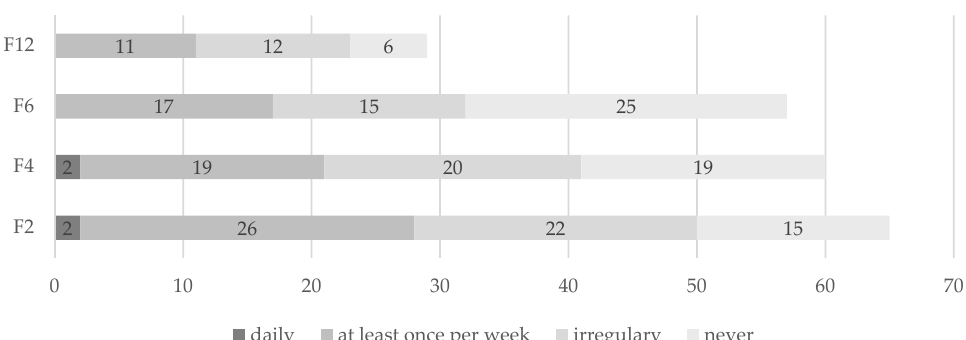
Figure 4. Sustained use of practical tips contained in videos of the app. Notes: Presentation in num- bers of participants. Abbreviations: F2 = two months after the intervention; F4 = four months after the intervention; F6 = six months after the intervention; F12 = twelve months after the